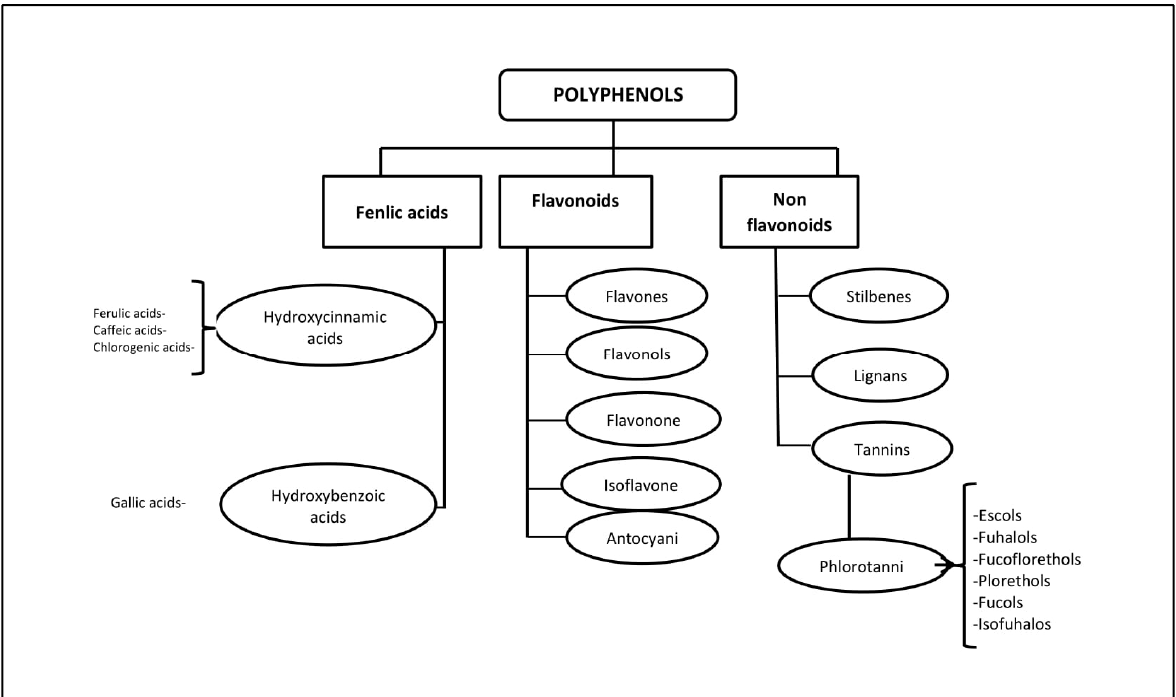
Figure 1. Classification of polyphenols and six main subclasses of seaweed phlorotannins.